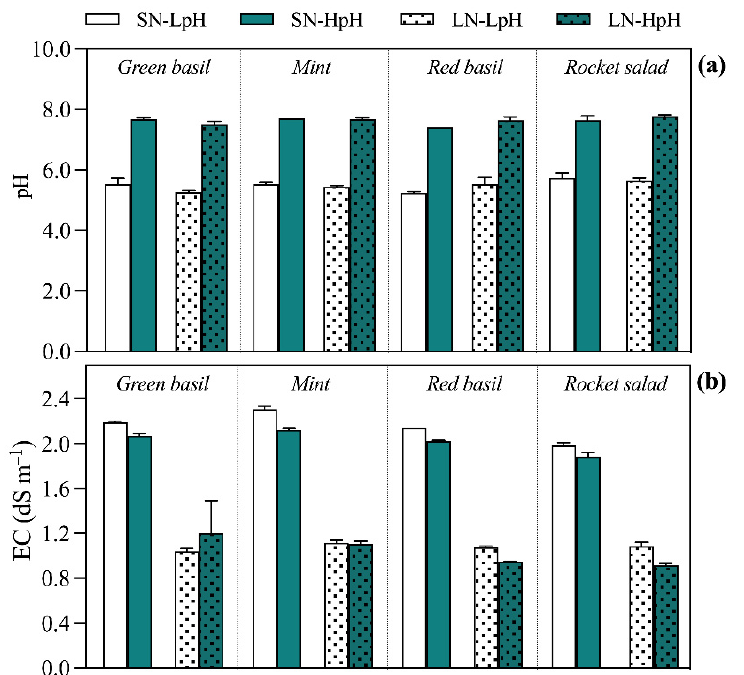
Figure 1. Average pH ( a ) and EC ( b ) of nutrient solutions measured during the trial. SN-LpH = standard nutrient concentration and standard pH (control); SN-HpH = standard nutrient concentration and high pH; LN-LpH = low nutrient concentration and standard pH; and LN-HpH = low nutrient concentration and high pH. Bars represent average values during all cultivation period + SD.